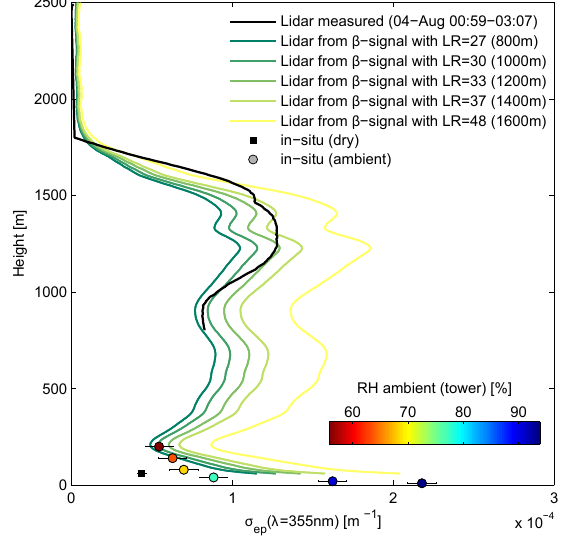
Fig. 11. Lidar and in-situ measurements of the aerosol extinc- tion coefficient σ ep at λ = 355nm (4 August 2009, 00:59–03:07). Black line: Direct LIDAR measurement of σ ep ; Colored lines: σ ep calculated from the backscatter signal using measured LIDAR ratios (LR) obtained from mean values of different height levels ( ± 100m); black square: σ ep measured in-situ at dry conditions; colored circles: σ ep brought to ambient conditions (color code de- notes the ambient RH measured at the tower, error bars are retrieved via Gaussian error